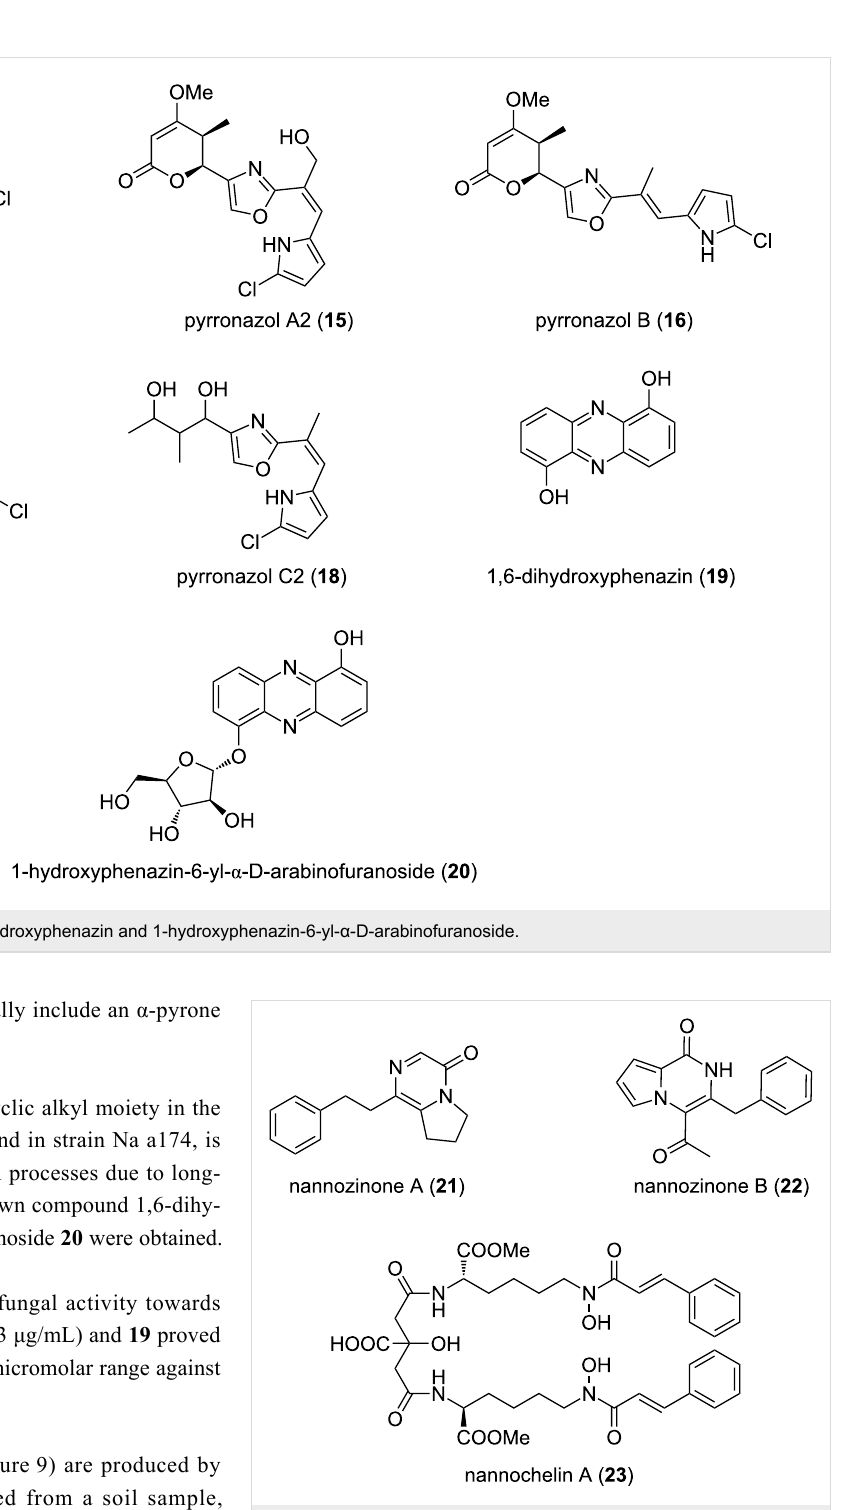
Figure 9: Structures of nannozinones A + B and nannochelin A from N. pusilla strain MNa10913.